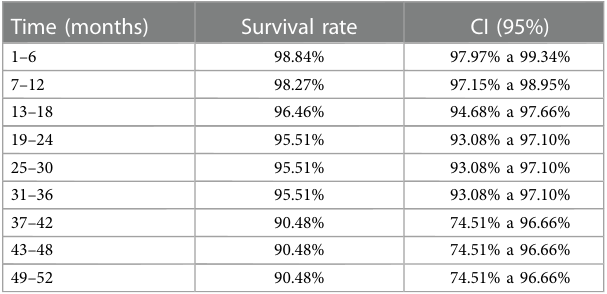
TABLE 2 Survival rate and con fi dence interval (95% CI) according to implant placement period. Time